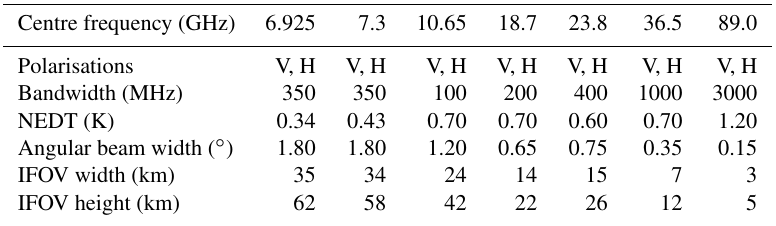
Table 1. Sensor characteristics of AMSR2 aboard JAXA’s GCOM-W satellite. Vertically and horizontally polarised channels are notated by V and H, respectively. Specification NEDT values are shown (Imaoka et al., 2010). Note that additional 89GHz channels exist on AMSR2 but are not included as they were not used